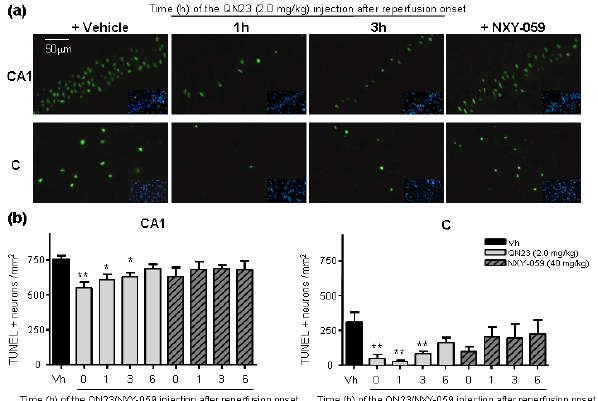
Figure 5. Therapeutic window of QN23 studied by TUNEL assay (apoptosis). Brain sections of ischemic animals from Figure 4 were used for apoptosis detection by TUNEL assay in the hippocampal CA1 (CA1) and cortical (C) regions and imaged by fluorescence microscopy (in green). ( a ) Representative images of CA1 or C regions from vehicle- and QN23-treated animals at 1 h or 3 h of reperfusion and NXY-059-treated animals at 0 h of reperfusion, after apoptosis detection by TUNEL assay and the corresponding Hoechst counterstaining. TUNEL-positive cells detected within CA1 and C regions were counted as described in the Materials and Methods section. ( b ) Bar graph representations of TUNEL-positive cells quantified in brain sections from vehicle-, QN23-, and NXY-059-treated animals in CA1 and C regions. For each group, 6–10 independent animals (as described in Figure 4) were averaged; error bars indicate the SE. * p < 0.05 and ** p < 0.01, compared with vehicle (Vh) by Dunnett’s post-test, after